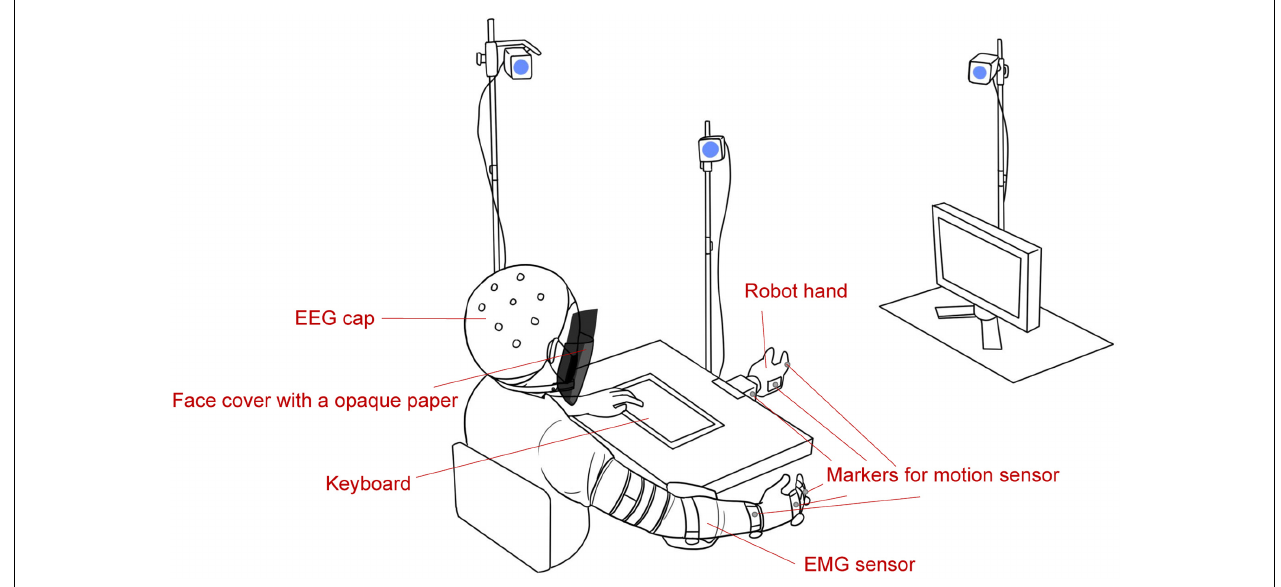
FIGURE 1 | Experimental environment (not to scale). EMG, electromyography; EEG, electroencephalogram.